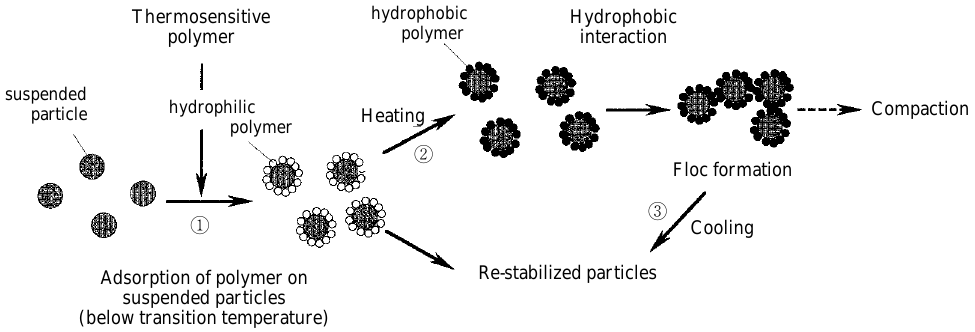
Fig. 1 Mechanism causing flocculation of suspended particles by using a thermosensitive